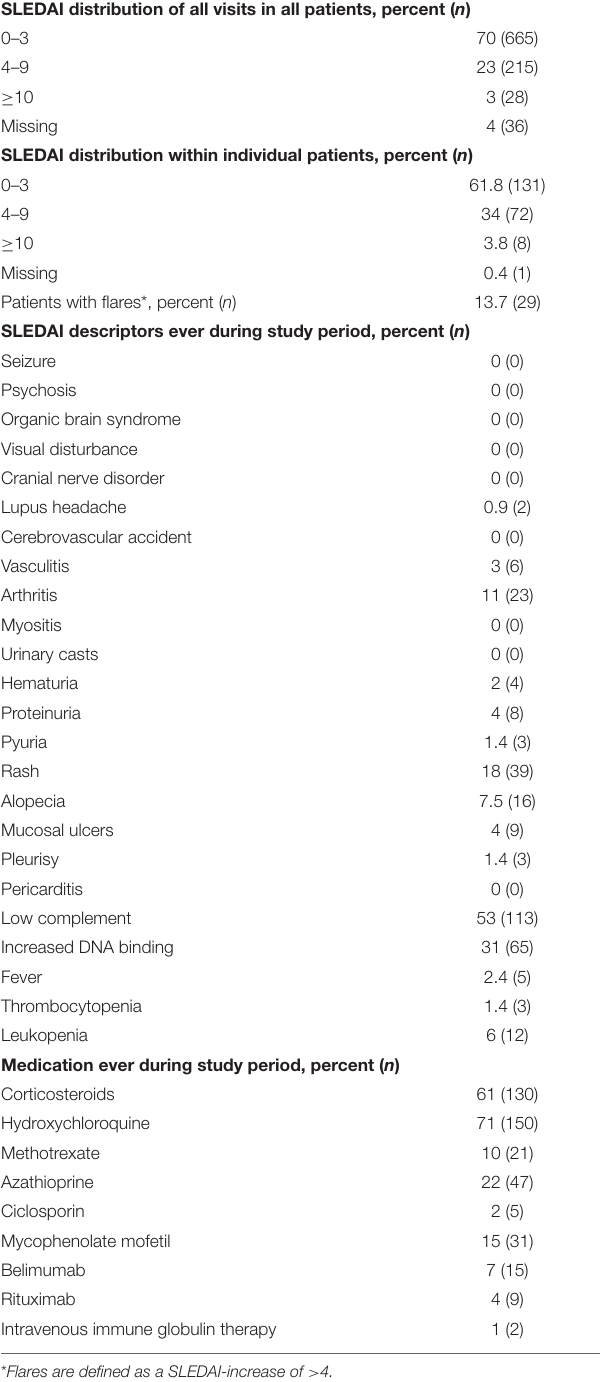
TABLE 2 | Distribution of disease activity and medications. SLEDAI distribution of all visits in all patients, percent ( n )